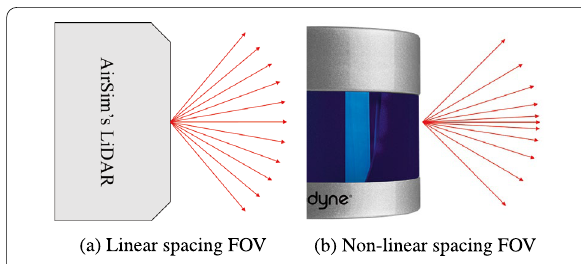
Fig. 10 LiDAR FOV. The LiDAR in the simulator does not reproduce non-linear spacing of FOV which the real sensor has